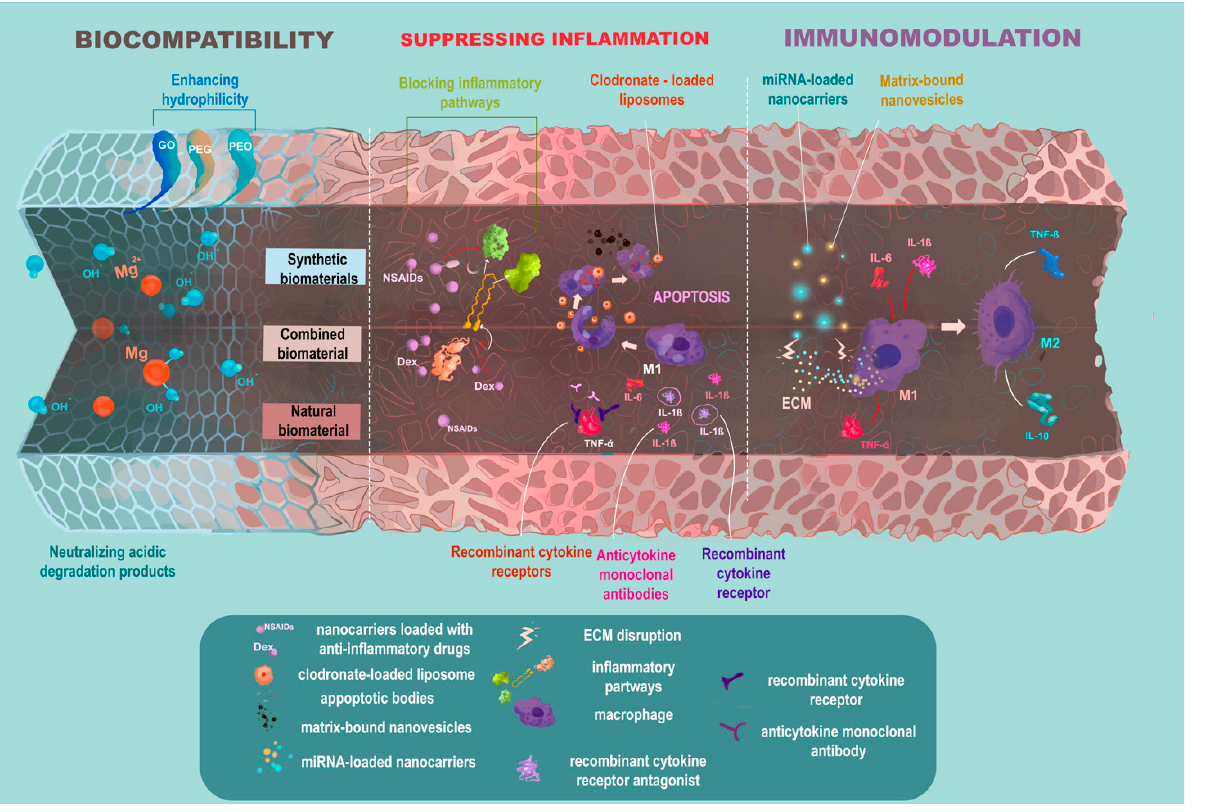
Figure 1. Evolution of the biocompatibility paradigm in tissue engineering. Excessive post-implan- tation inflammation is a common adverse effect in tissue engineering, and therefore biocompatibil- ity is the cornerstone for constructs applied in tissue regeneration. Various strategies enhancing the construct’s biocompatibility have been proposed, including the use of natural biomaterials or func- tionalizing synthetic biomaterials in a way that would neutralize their degradation products or en- hance their hydrophilicity. Yet, there is a trend of changing the paradigm of bioinert tissue con- structs to bioactive ones. Thus, not only should they be biocompatible, but they should also be func- tionalized in a way that would target inflammation. Different strategies suppressing inflammation such as blocking inflammatory pathways or inducing inflammatory cells’ apoptosis have been pro- posed. However, state-of-the-art approaches suggest immunomodulation rather than suppressing inflammation for successful tissue remodeling and regeneration. In this light, miRNAs known for their unique ability to regulate multiple processes including macrophage polarization are of great interest as therapeutic agents.